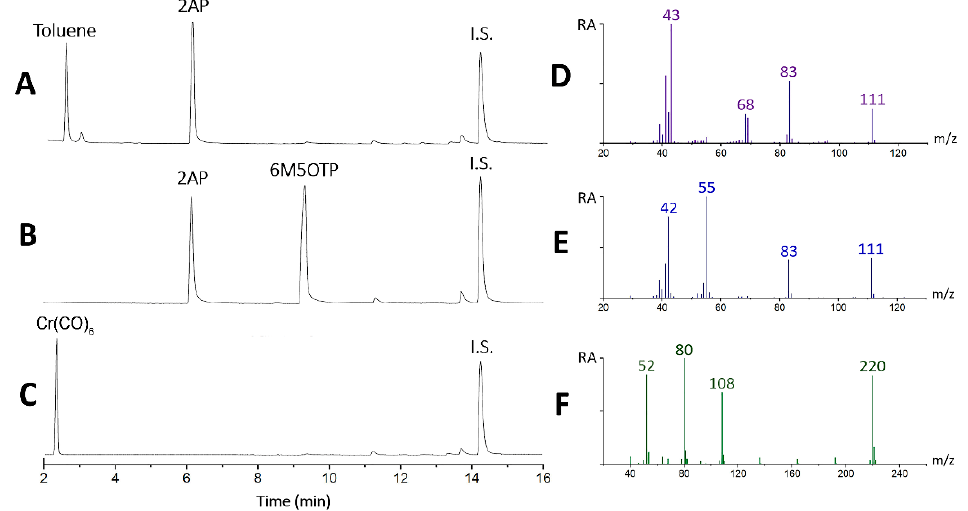
Figure 2. GC–MS chromatogram of synthetic 2AP in toluene ( A ), DCM ( B ) and after the addition of Cr(CO) 6 ( C ). Mass spectrum of 2AP ( D ), 6M5OTP ( E ) and Cr(CO) 6 ( F ). Cr(CO) 6 ( C ). Mass spectrum of 2AP ( D ), 6M5OTP ( E ) and Cr(CO) 6 ( F